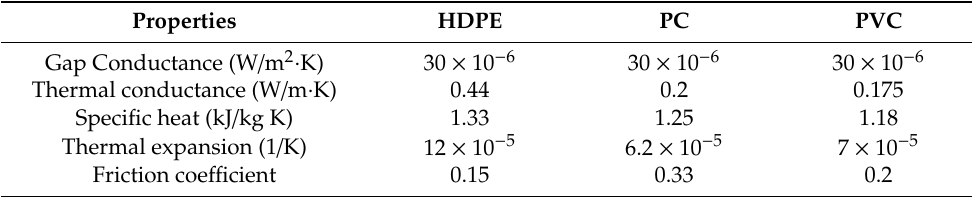
Table 2. Thermal parameters used in the model and friction coe ffi